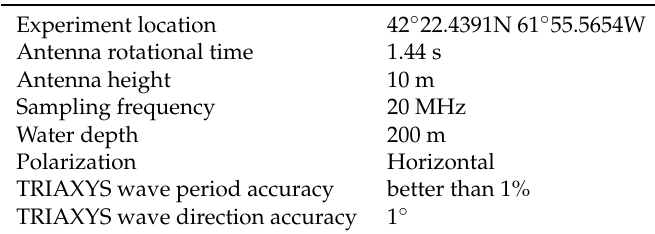
Figure 7. Locations of wave buoy and radar during the experiment on 1 December 2008. Table 2. Experiment setup: Radar and buoy